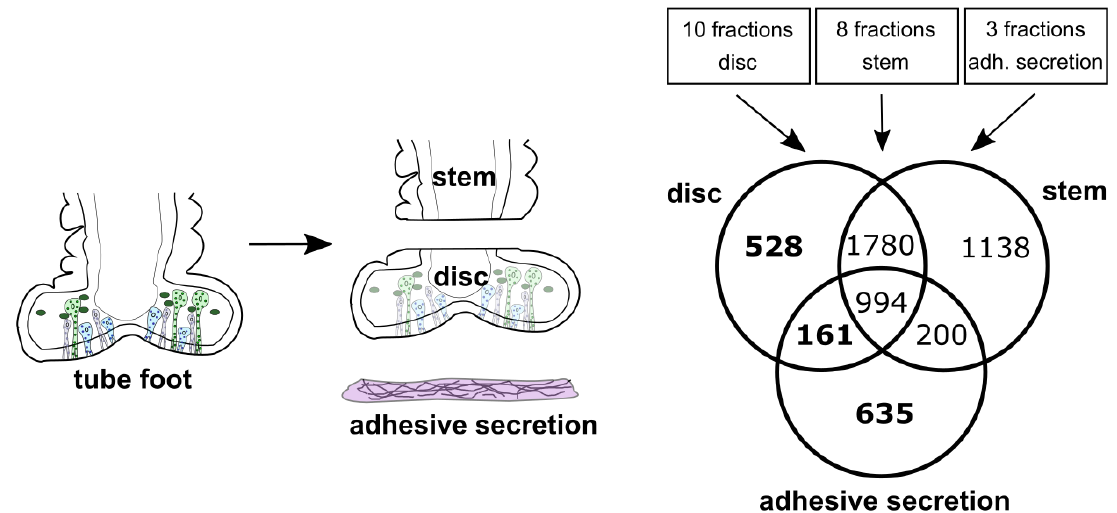
Figure 4. Illustration of biological samples used for differential proteomics and diagram indicating the number of transcripts allocated to disc-, stem- and adhesive secretion samples after re-mapping of the Lebesgue et al. proteome data to the P. lividus transcriptome. A total of 1324 transcripts (emphasized in bold) were used for downstream analysis.